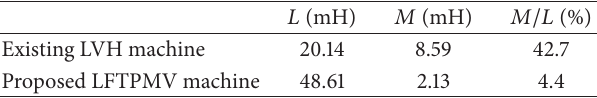
Table 2: Comparison of self-inductance and mutual